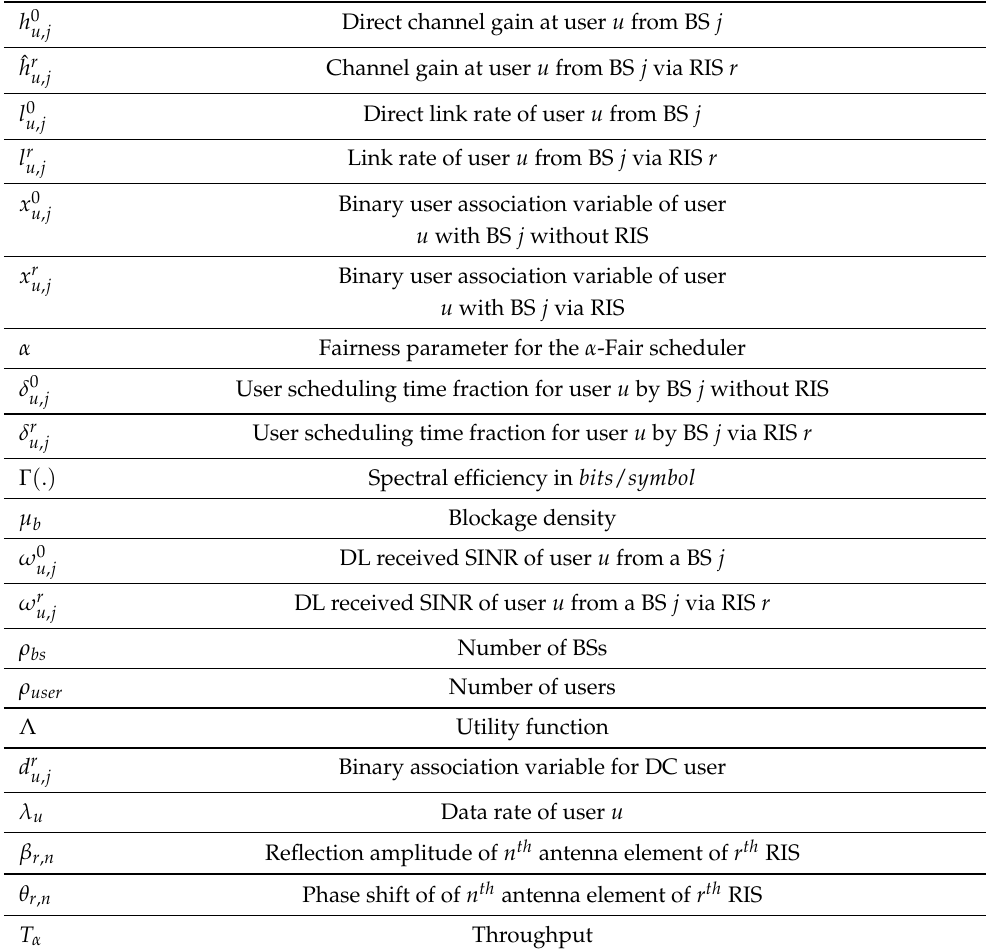
Table 1. Mathematical